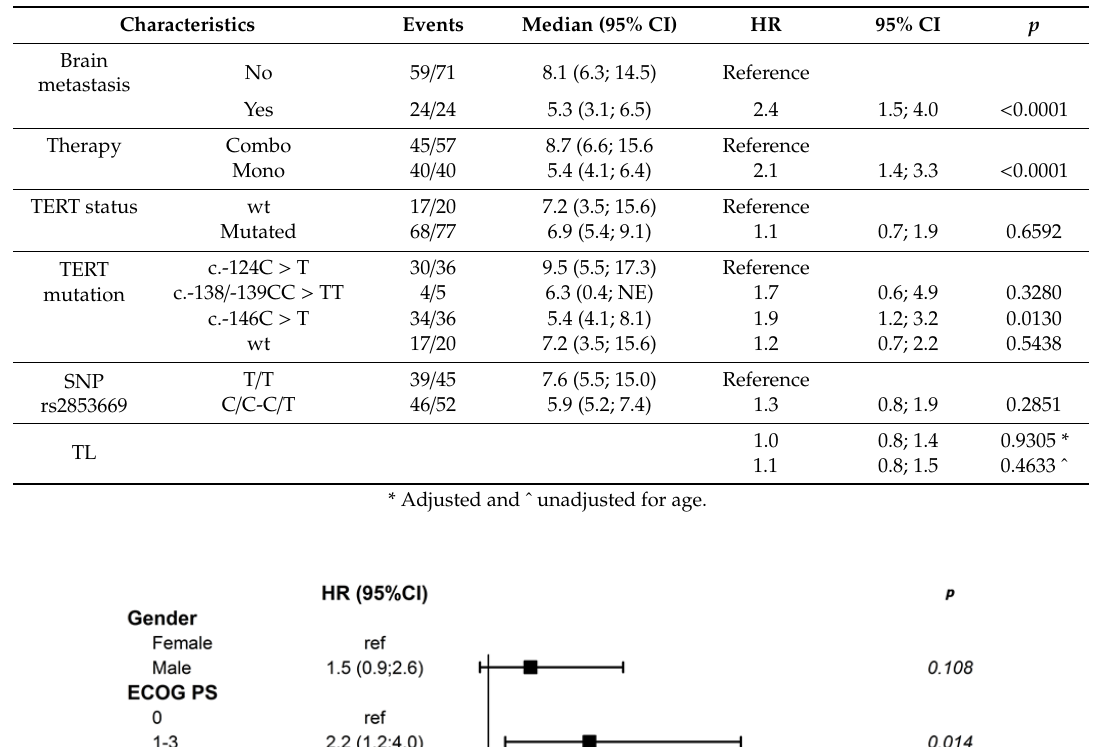
Table 2. Univariate Cox proportional hazards models of progression free survival. CI — confidence interval; HR — hazard ratio; NE — not estimable.